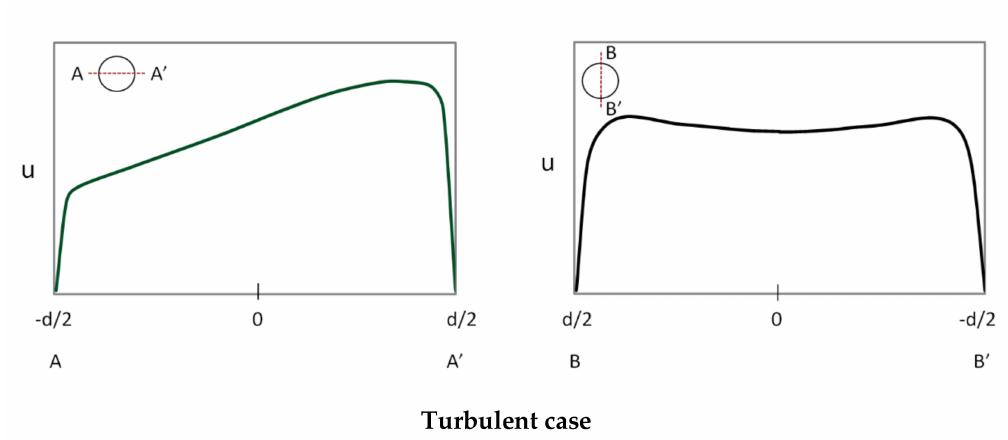
Figure 2. Velocity profiles for helical one-phase flow under laminar regime (upper part) and turbulent regime (lower part) ( u = flow velocity; d = pipe internal